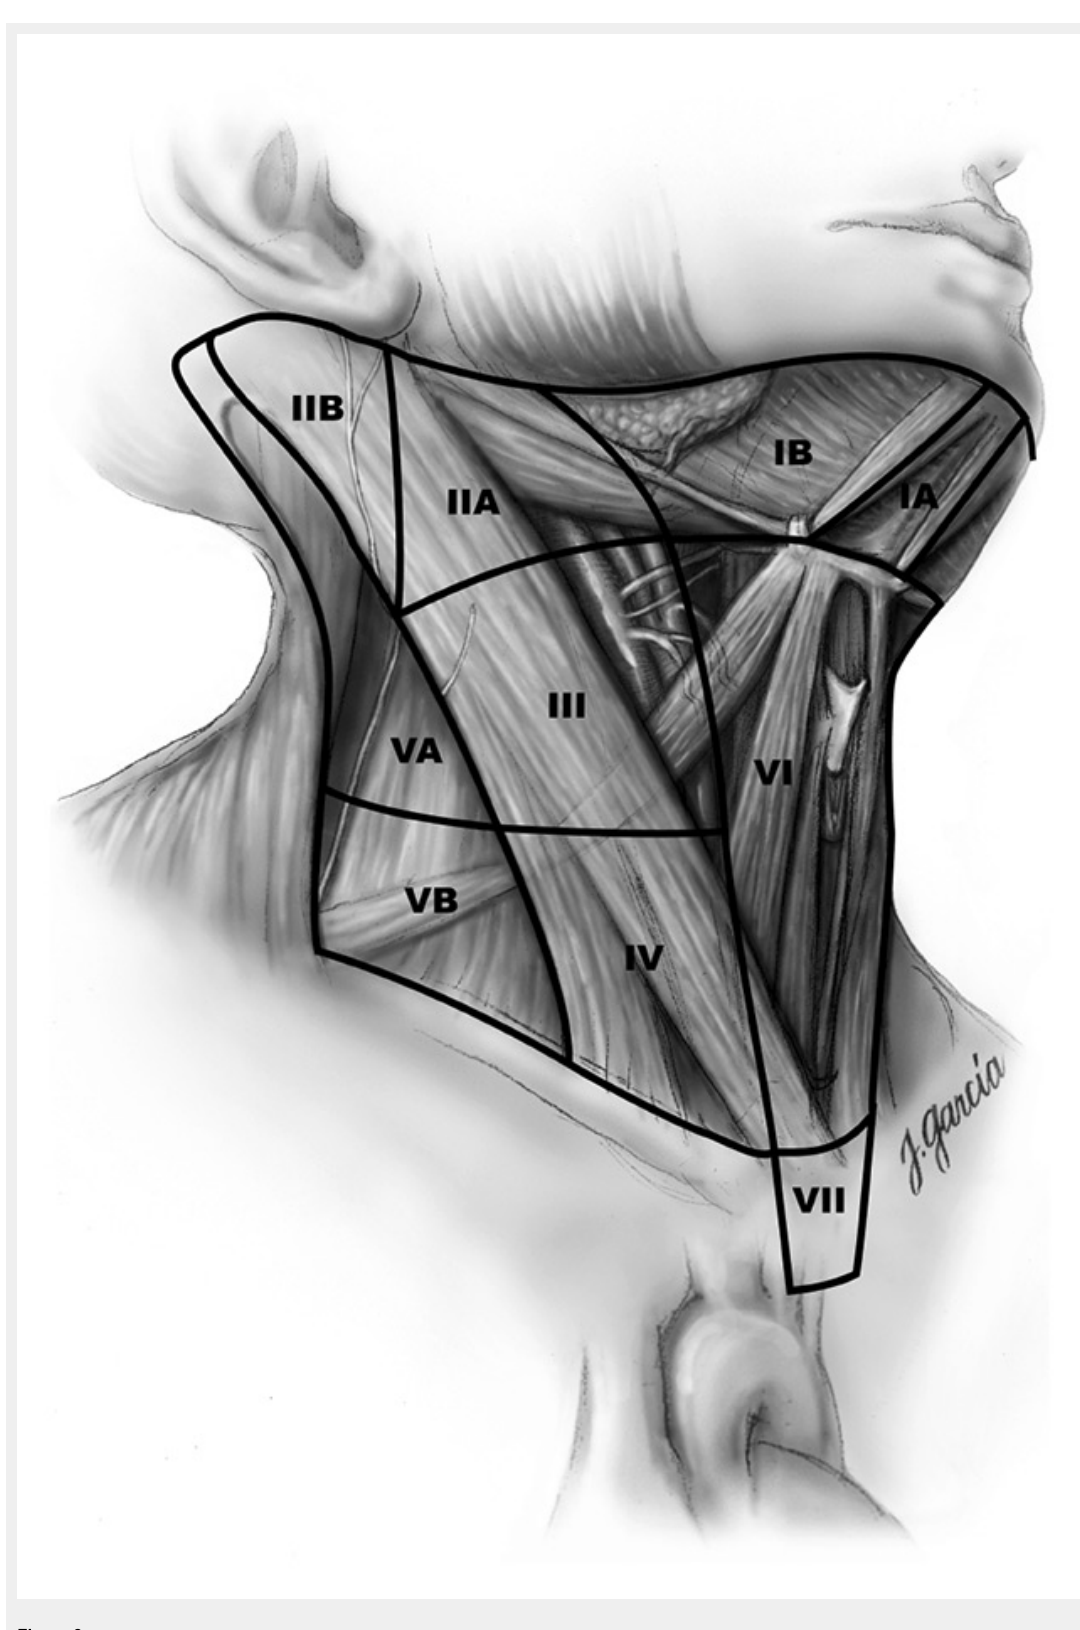
Figure 3 Schematic right anterior oblique view indicating levels of the neck and upper mediastinum relevant to neck dissection in thyroid cancer. Reprinted from Carty SE, et al, Consensus statement on the terminology and classification of central neck dissection for thyroid cancer. Thyroid.